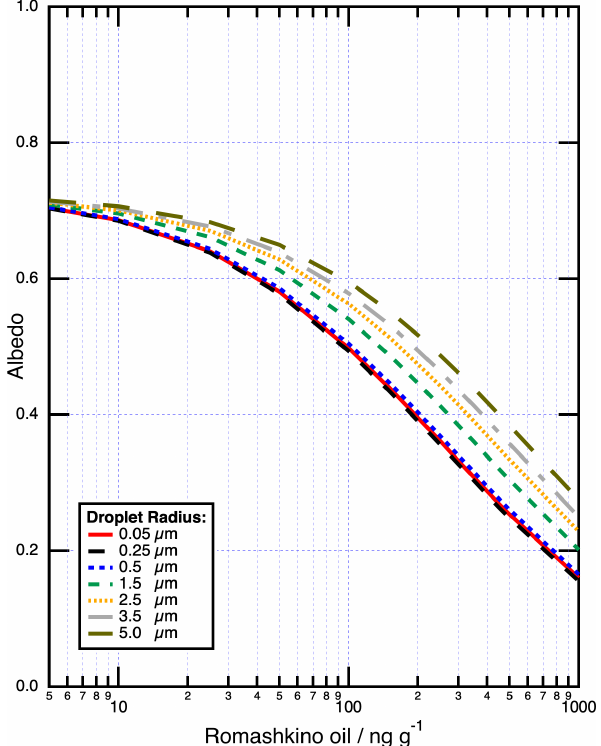
Figure 3. The albedo response of melting sea ice as mass ra- tios of Romashkino oil increase (0–1000ngg − 1 ) at a wavelength of 400nm. The different coloured lines represent different log- normally distributed droplet sizes with median radii of 0.05–5.0µm. The melting sea ice is quasi-infinite, and the properties are described in Table 1. These data demonstrate the sea ice albedo to be most re- sponsive to the smallest droplet sizes (0.05–0.5µm).